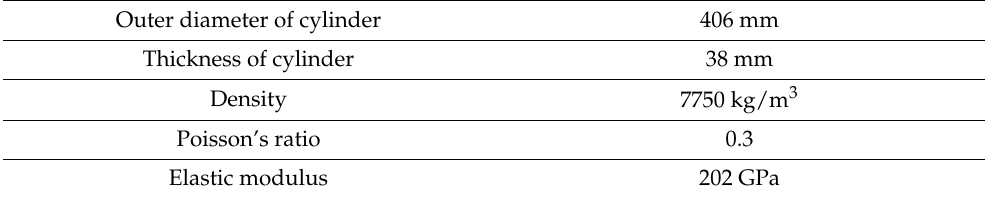
Table 1. The simulated